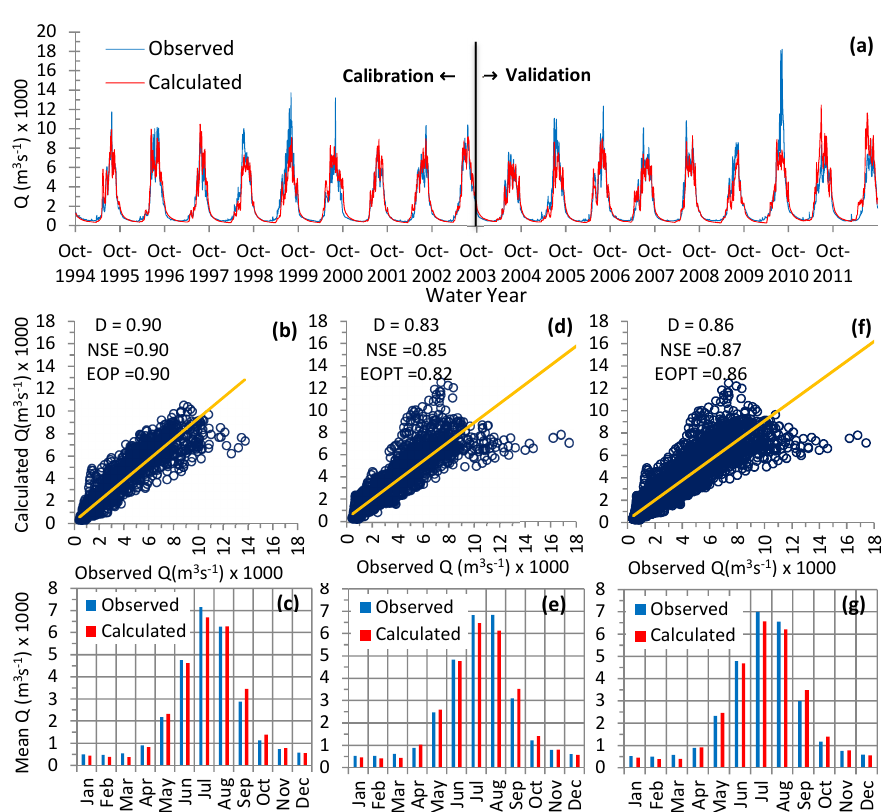
Figure 6. ( a ) Results of calibration (1994/95–2002/03) and validation (2003/04–2011/12) of the UBC watershed model for the UIB at Besham Qila; ( b , c ) for the calibration period only; ( d , e ) for the validation period only; ( f , g ) for the whole